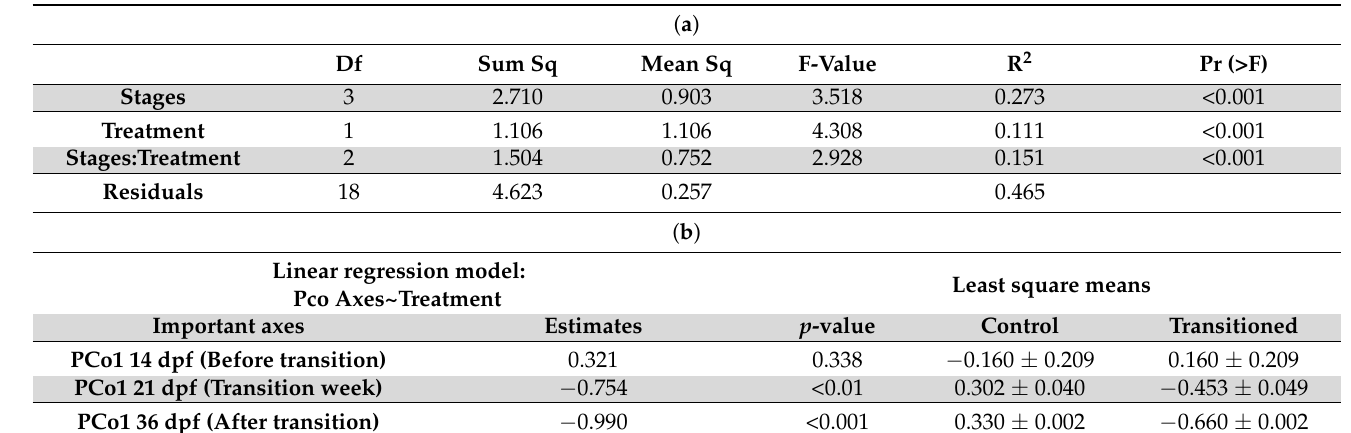
Table 2. ( a ) PERMANOVA analysis quantifying sources of variability among larval lake sturgeon GI tract microbiota community composition that differed significantly among sampling times and between treatments. A significant interaction was also observed between treatment and sampling times (PERMANOVA test pseudo-F = 2.928, R 2 = 0.087, p < 0.001; permutation = 1000). ( b ) Goodness of fit from linear regression model (R 2 ), p -value, and least-square means analyses performed on significantly important PCo axes calculated separately for each sampling period. PCo axis 1 for period 21 dpf and PCo axis 1 for period 36 dpf showed significant differences across diet treatment influencing the microbial community composition, but none of PCo axis for period 14 dpf was found to be